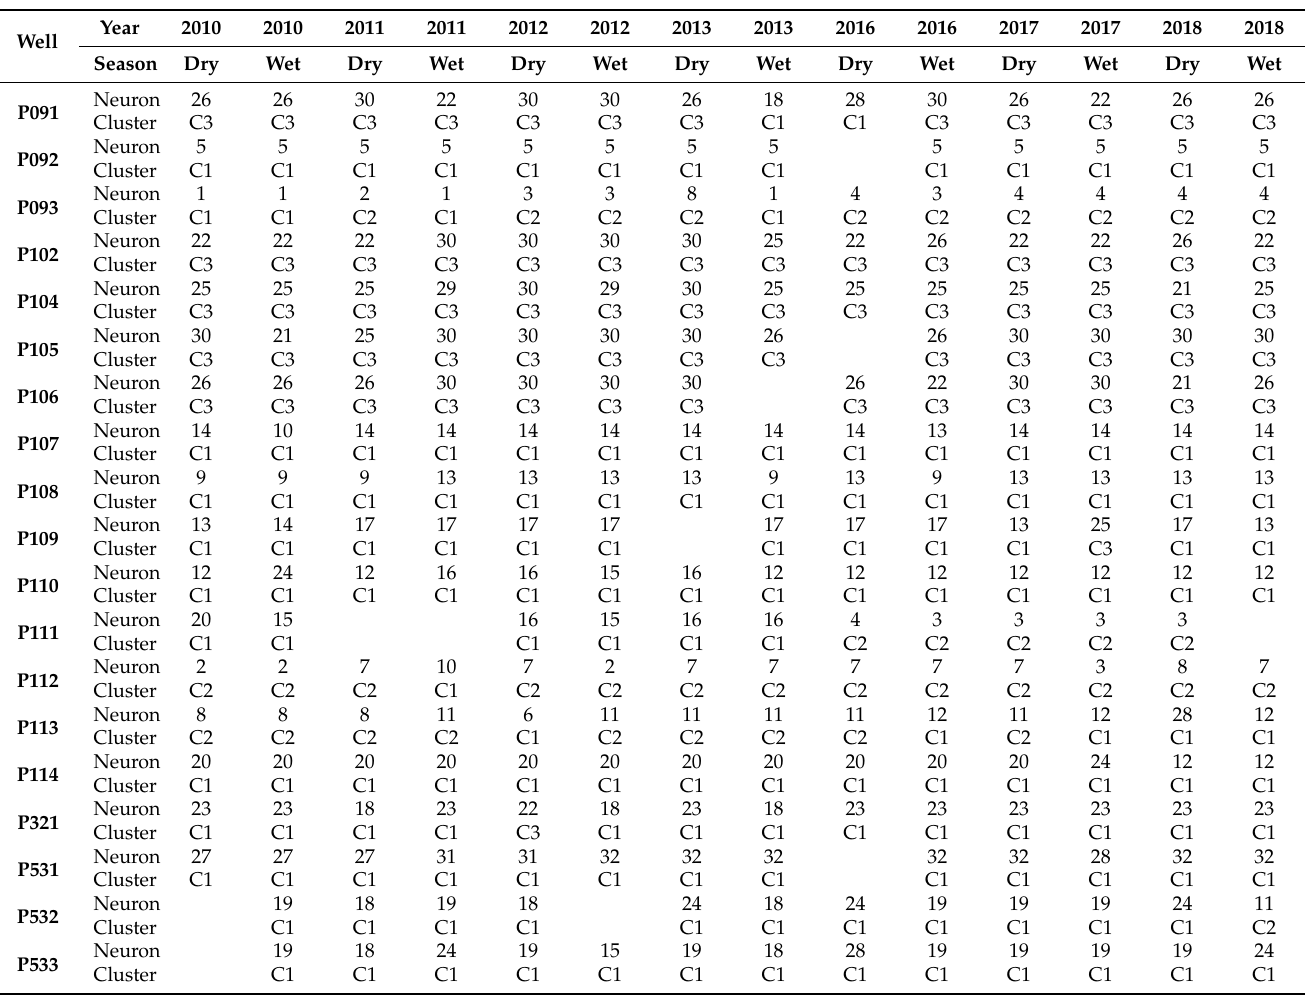
Table 1. Position of the different wells within the SOM neurons and